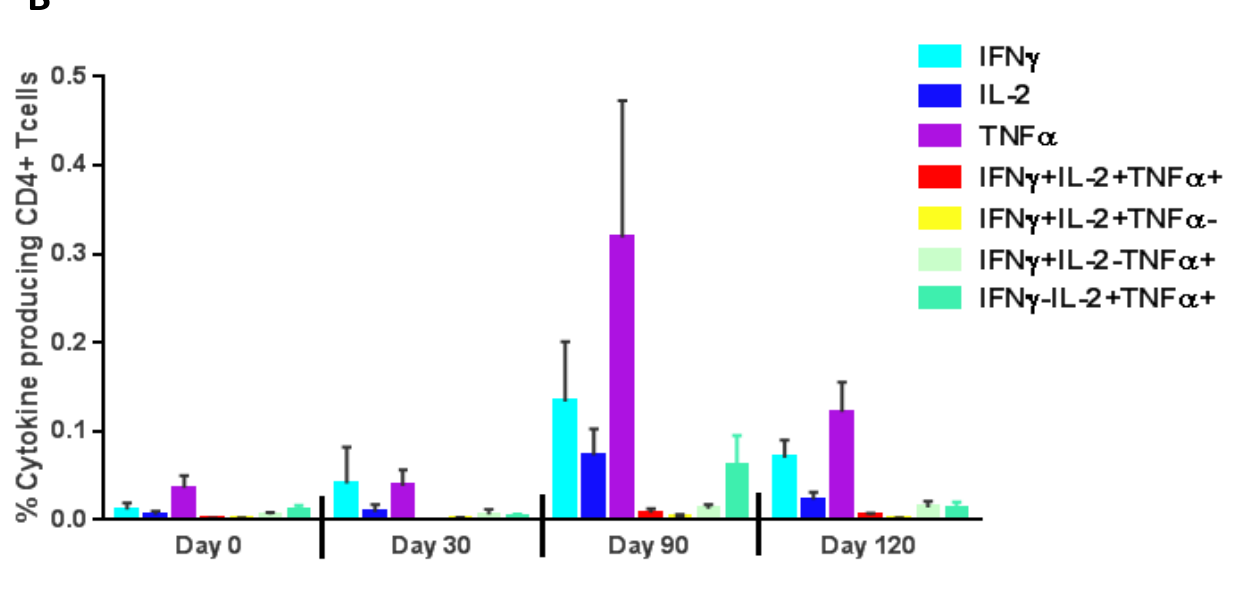
Figure 3. Levels of anti-Sm14 antibody classes and cytokine production stimulated by vaccination. ( A ) ELISA antibody results. ( B ) Percentage of CD4 + T cells expressing combinations of IFN γ , TNF α , and IL-2 production in CD4+ T cells on days 0, 30, 90, and 120. The comparison of p -values to baseline was performed for the vaccinated group (day 0); * p -values at the 0.05 significance level. Sm14+GLA-SE vaccination elicited robust cytokine responses. Cytokine profiles show increased TNFα, IFN ɣ , and IL-2 in vaccinated individuals on days 90 and 120. The [11] (Figure 3).